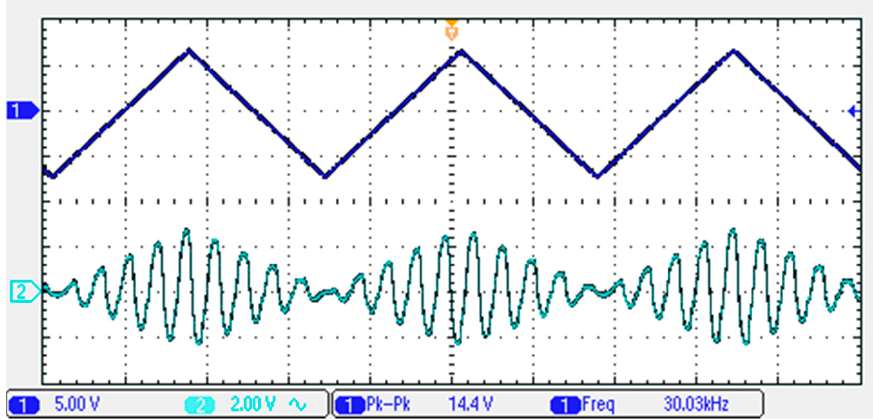
Figure 18. Measured result of operation as an AM signal generator (channel 2) when I B 2 is the applied triangular signal (channel 1).